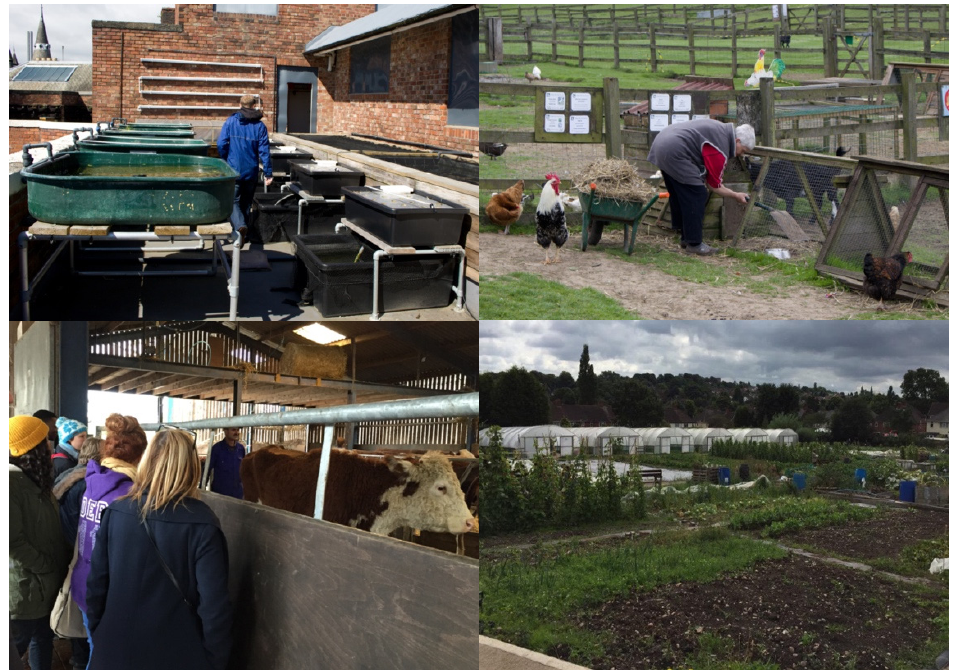
Figure 1. An overview of some of the urban farms explored in 2018 and 2019. Clockwise from top left—Farm Urban, Woodgate Valley Urban Farm, Wythenshawe Urban Farm, Salop Drive.